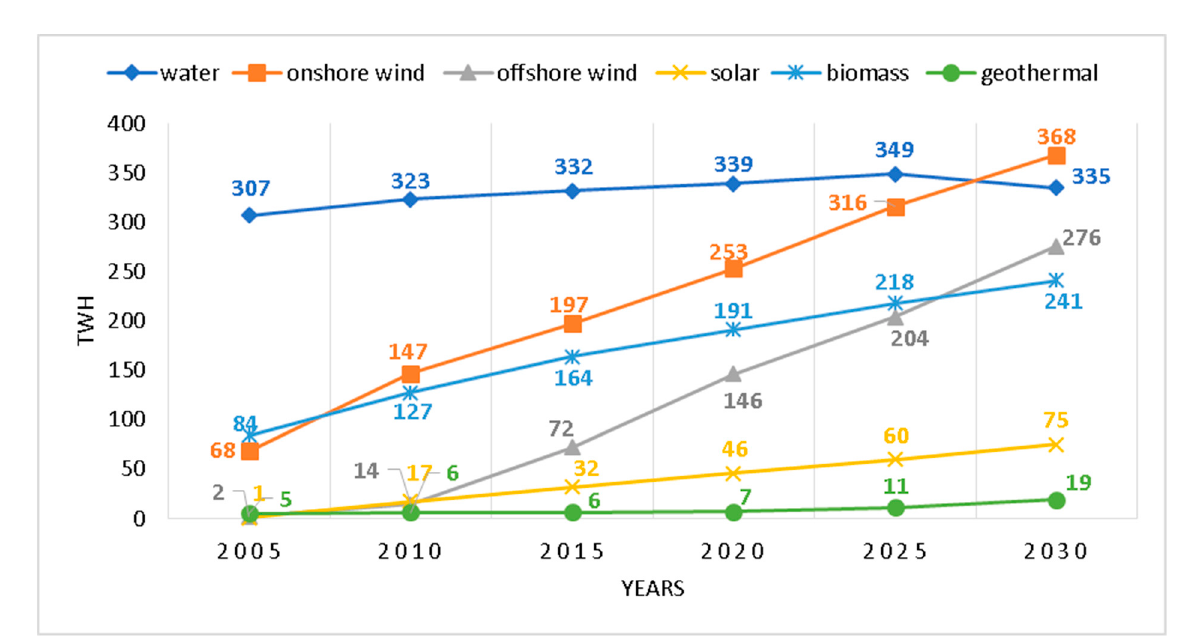
Figure 1. Number of nuclear reactors in selected countries and construction delays—own study based on [1,38–40].